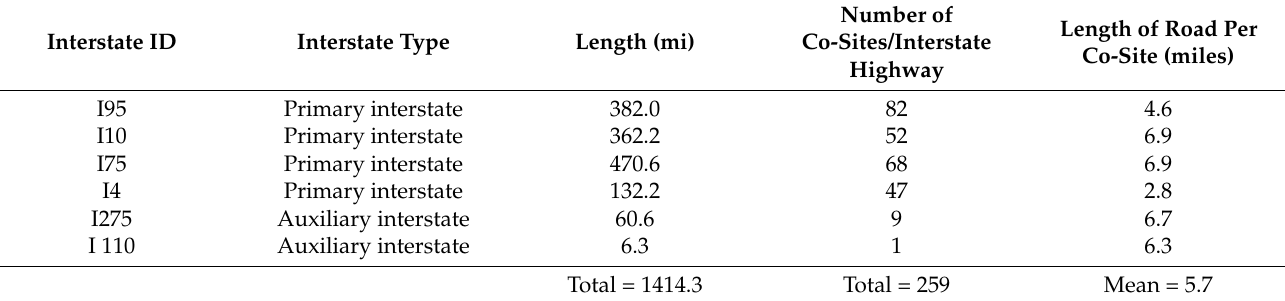
Table 1. Interstate highways and co-sites under